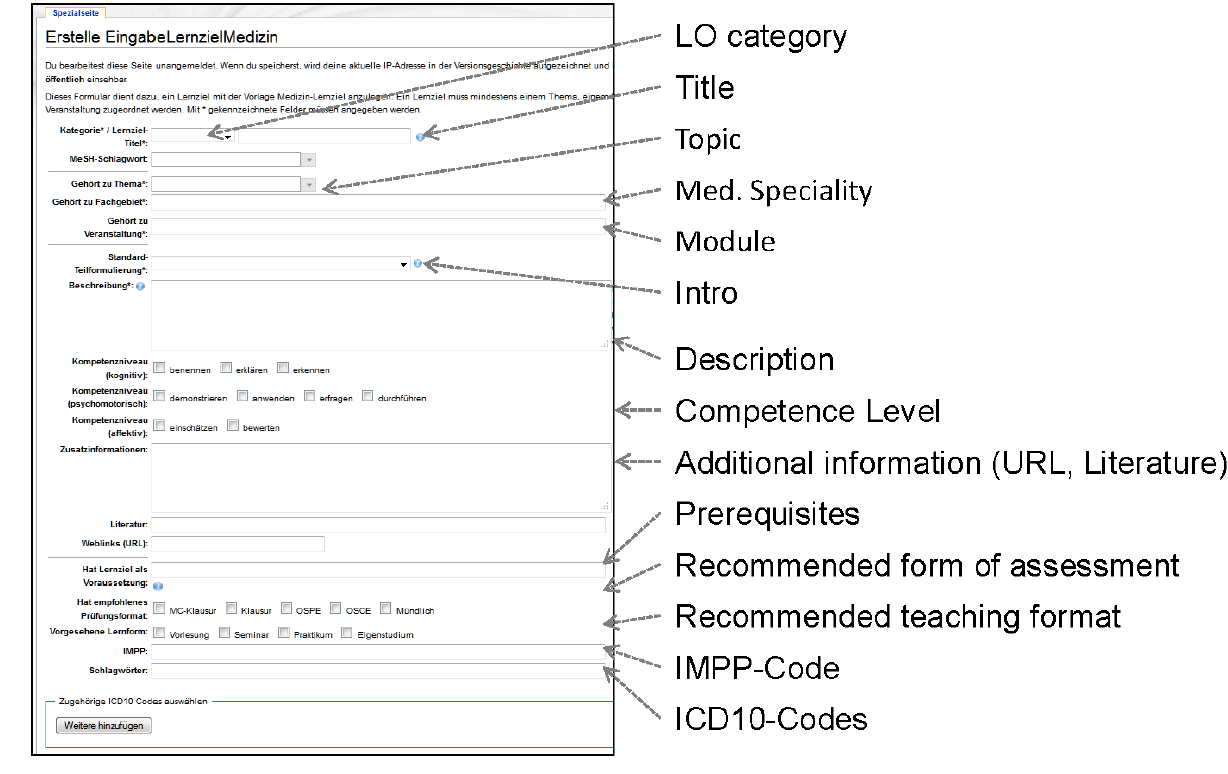
Figure 6. Form for defining a medical learning objective.